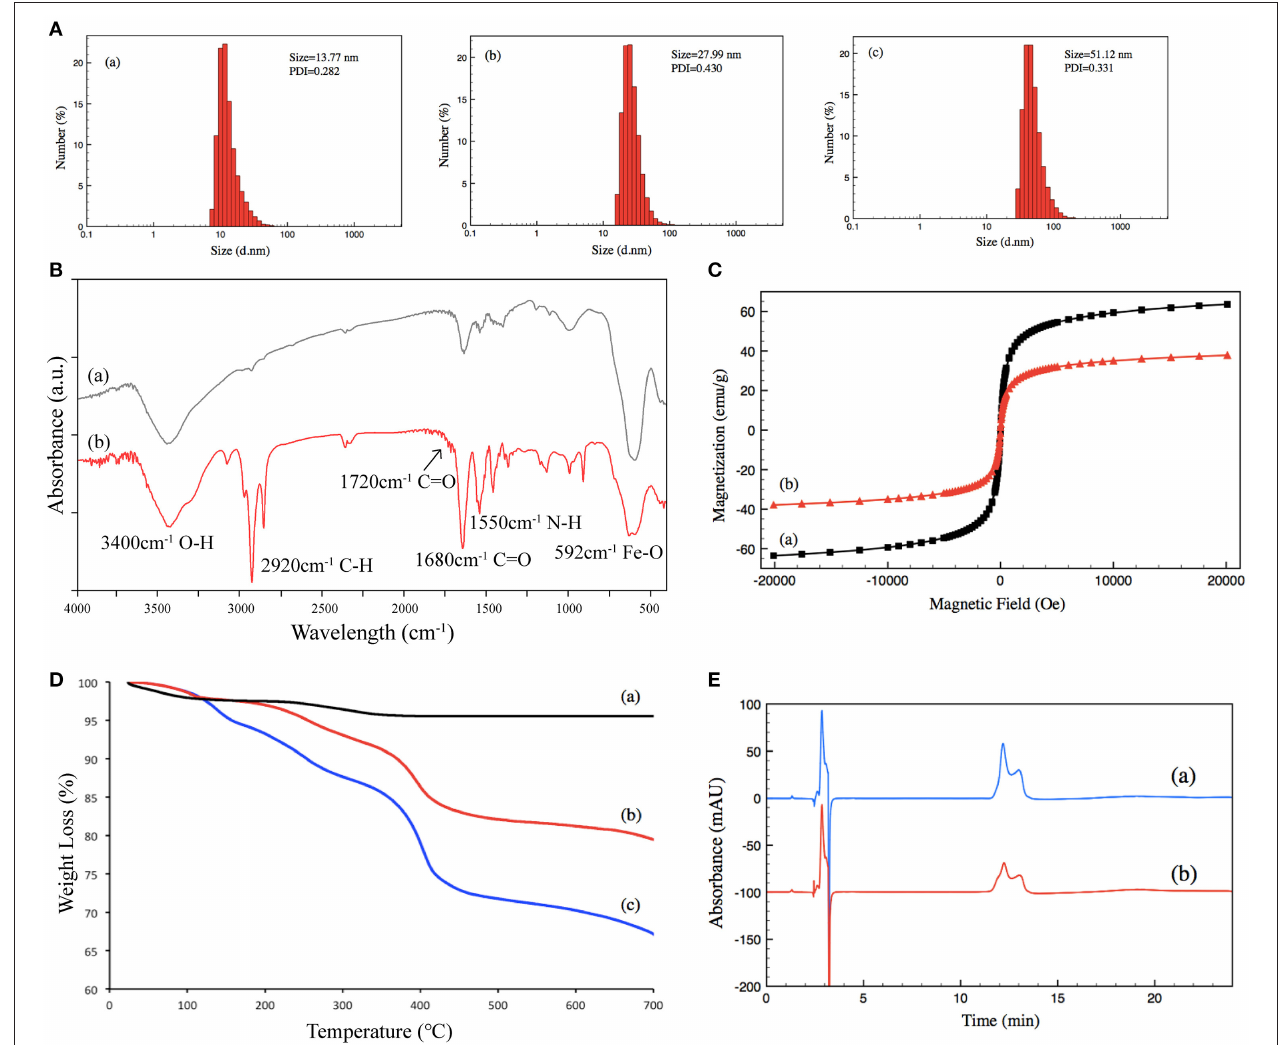
FIGURE 2 | (A) Size distribution of (a) un-grafted magnetic nanoparticles, (b) poly-NIPAM grafted magnetic nanoparticles, and (c) poly-NIPAM -b -poly-UnAl copolymer-grafted magnetic nanoparticles. (B) FT-IR spectra of (a) un-grafted magnetic nanoparticles and (b) poly-NIPAM- b -poly-UnAl copolymer-grafted magnetic nanoparticles. (C) Magnetization curves at 25 ◦ C for (a) un-grafted magnetic nanoparticles and (b) poly-NIPAM -b -poly-UnAl copolymer-grafted magnetic nanoparticles. (D) TGA curves of (a) un-grafted magnetic nanoparticles, (b) poly-NIPAM grafted magnetic nanoparticles, and (c) poly-NIPAM- b- poly-UnAl copolymer-grafted magnetic nanoparticles. (E) HPLC spectra of (a) 0.5 µ g/ µ l BSA and (b) supernatant solution after the immobilization of BSA on poly-NIPAM- b -poly-UnAl copolymer-grafted magnetic